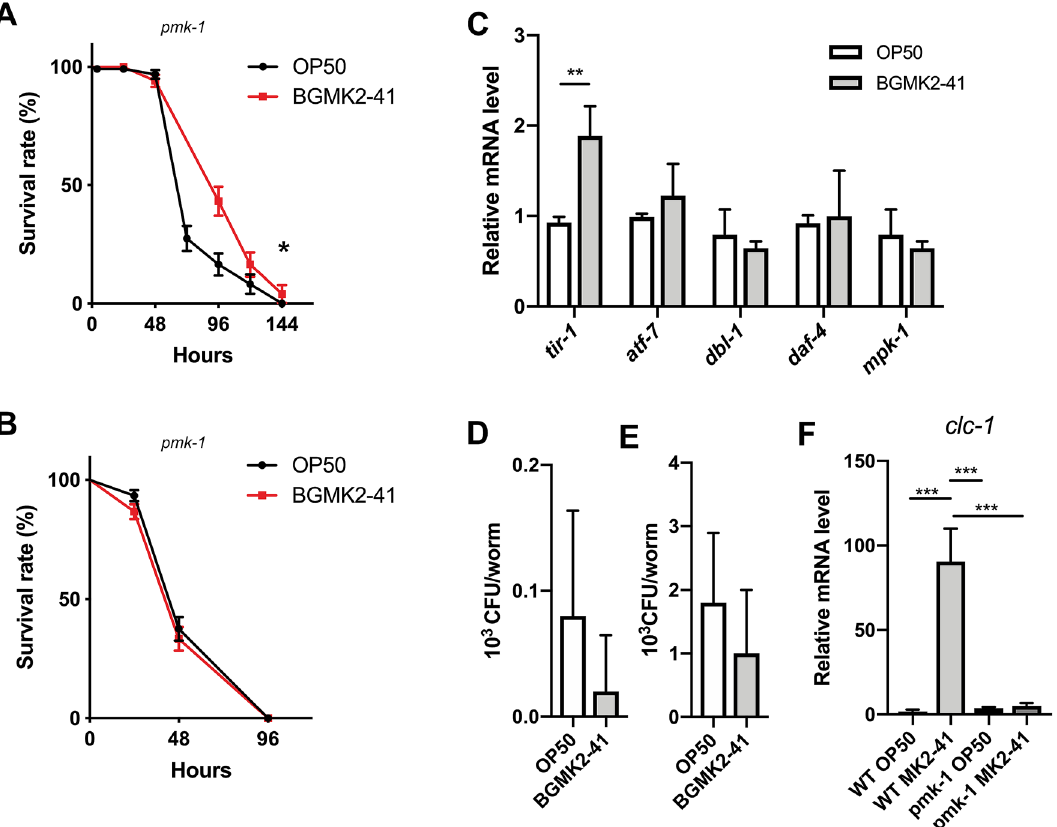
Figure 3. The p38 MAPK deficiency abrogates protective effects of Lactobacillus curvatus BGMK2-41. Survival curve of pmk-1 loss-of-function animals exposed to ( A ) S. aureus ATCC 25923 and ( B ) P. aeruginosa PA14 after overnight feeding of L4 stage worms with heat-inactivated control ( E. coli OP50) or BGMK2-41 bacteria (n = 25–30 worms per group, results are representative of 2 independent assays). ( C ) Expression of immune- related genes analyzed by qRT-PCR in the L4 stage of the pmk-1 mutant after overnight treatment with heat- inactivated BGMK2-41 (n = 3, three independent experiments). CFUs values of ( D ) S. aureus ATCC 25923 and ( E ) P. aeruginosa PA14 present in the pmk-1 deficient BGMK2-41 treated worms after 1 day of exposure to pathogens (n = 10 worms per group, results are representative of 2 independent assays). ( F ) Tight junction barrier assessment by determination of clc-1 mRNA levels in day 1 old WT and pmk-1 worms treated with heat- inactivated BGMK2-41 (results from three independent experiments). All values are presented as mean ± SD. Student’s t-test was used to compare the treated group relative to control. The log-rank (Mantel-Cox) test was used to assess the p-value in nematode killing assays (* P < 0.05, ** P < 0.01, *** P < 0.001). The statistical analysis and graphs were done in GraphPad Prism version 8.0.0 for Mac, GraphPad Software, www. graph pad.